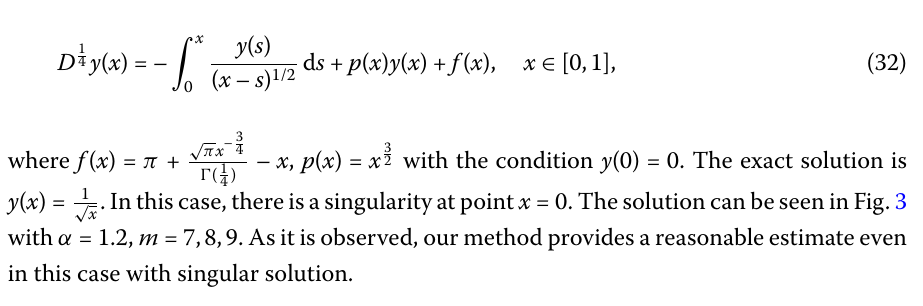
m increases and the FEFs method has smaller root-mean-square errors. The convergence rates of the numerical solutions with respect to the value of m are shown in Table